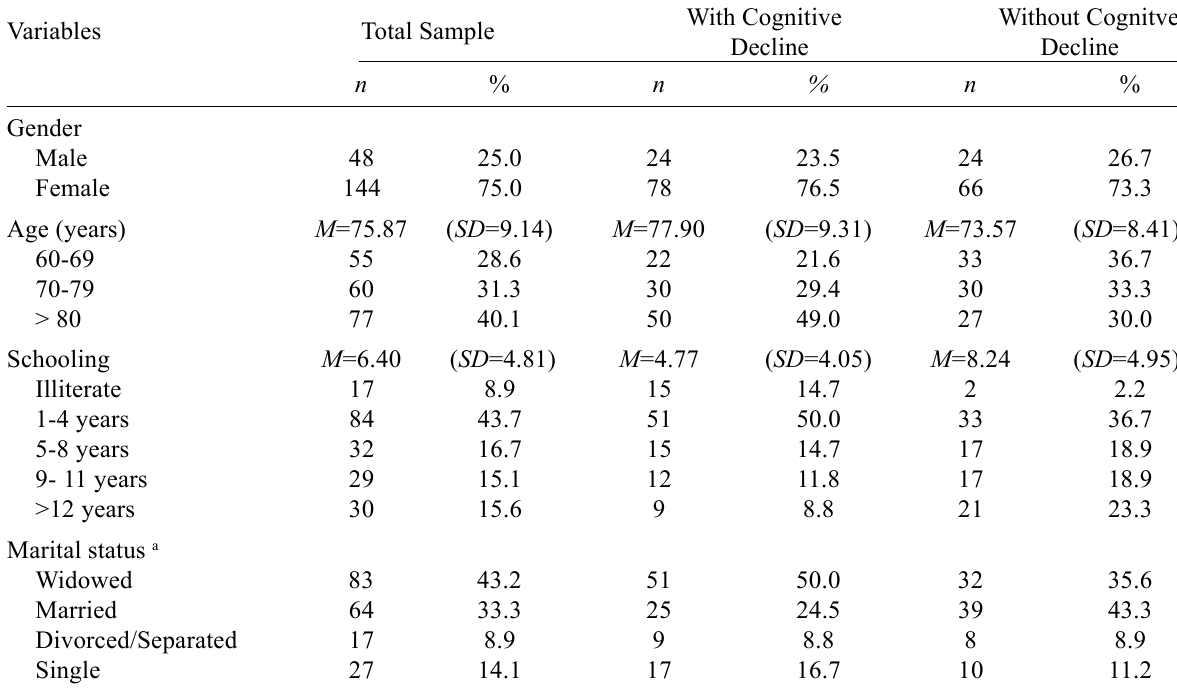
Table 1 Sociodemographic Results of the Total Sample and of the Groups Variables Total